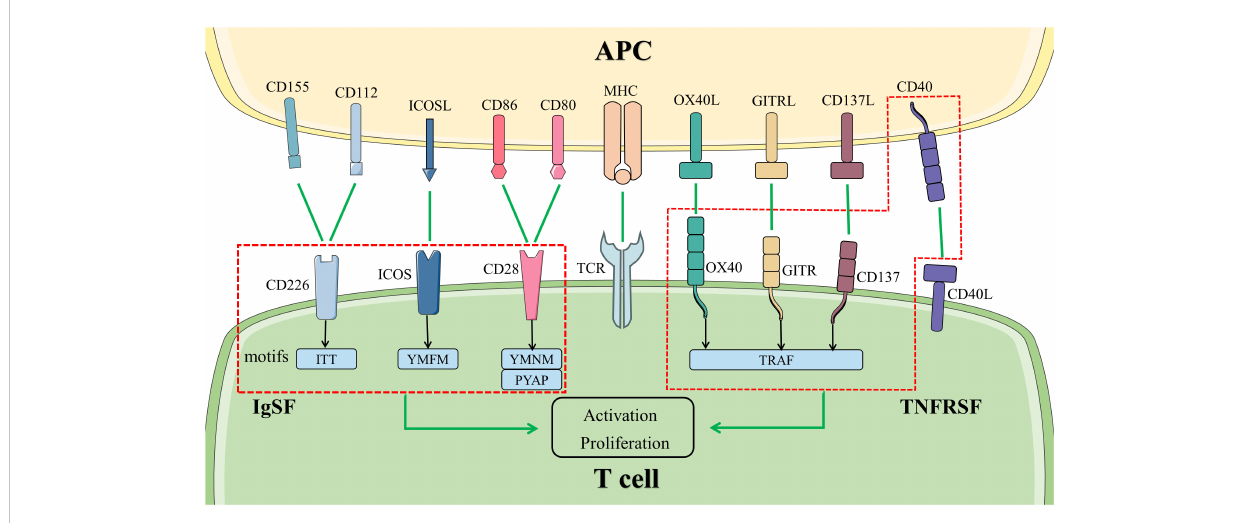
FIGURE 2 Co-stimulatory signal pathways in T cells. The activation and proliferation of T cells at least need two signals. The fi rst signal is provided by the binding of TCR to MHC with antigenic polypeptide processed by APC. Co-stimulatory molecules bind to the ligand or receptor presented by APCs, transmitting the second signal. The molecules in the left box are members of IgSF, activating the signal pathways downstream by different motifs in the cytoplasmic tail. The members of TNFRSF are represented in the right box. They bind to TRAF to activate the signal pathways downstream. Abbreviations: APC, antigen-presenting cell; GITR, glucocorticoid induced tumor necrosis factor receptor; ICOS, inducible T-cell co-stimulator; IgSF, immunoglobulin superfamily; MHC, major histocompatibility complex; TCR, T cell receptor; TNFRSF, tumor necrosis factor receptor superfamily; TRAF, tumor necrosis factor receptor-associated